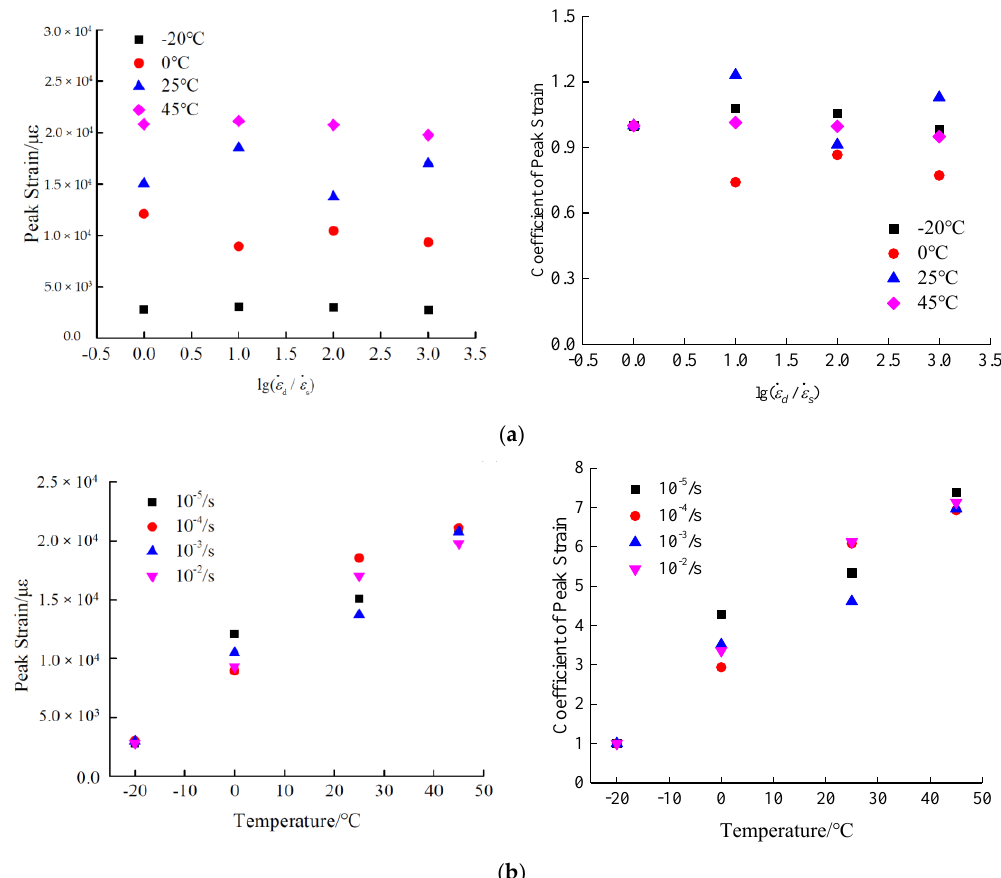
Figure 10. Temperature effect and strain rate effect on the peak strain. ( a ) strain rate effect; ( b ) Figure10. Temperatureeffectandstrainrateeffectonthepeakstrain. ( a )strainrateeffect;( b temperature effect.